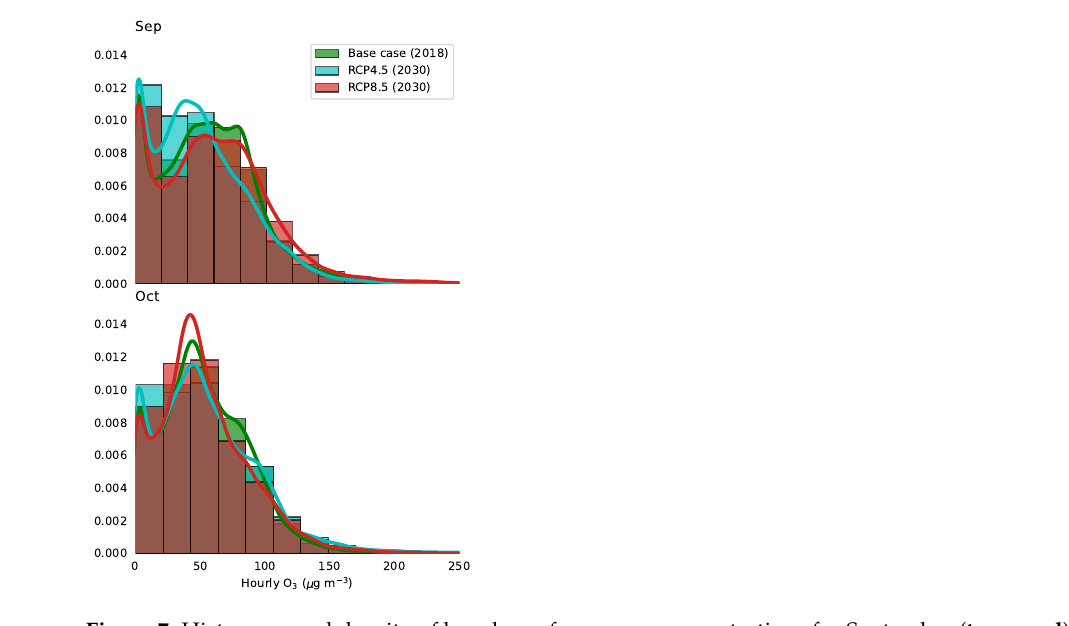
Figure 7. Histogram and density of hourly surface ozone concentrations for September ( top panel ) and October ( lower panel ) for all